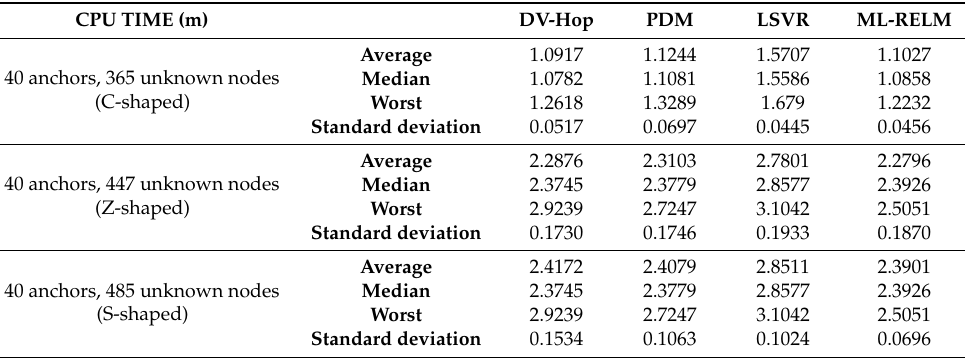
Table 1. Running time in the regular deployment.